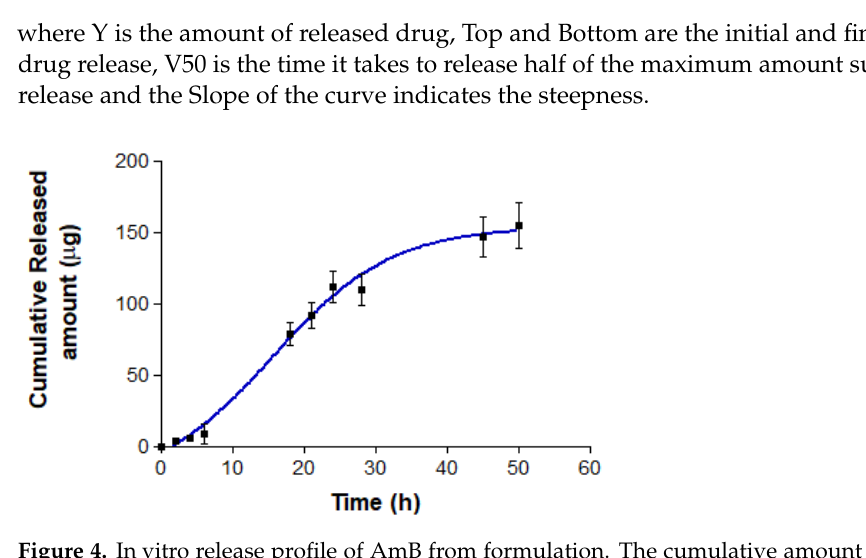
Figure 4. In vitro release profile of AmB from formulation. The cumulative amount released was plotted against time. Data represents mean ± SD ( n = 3).